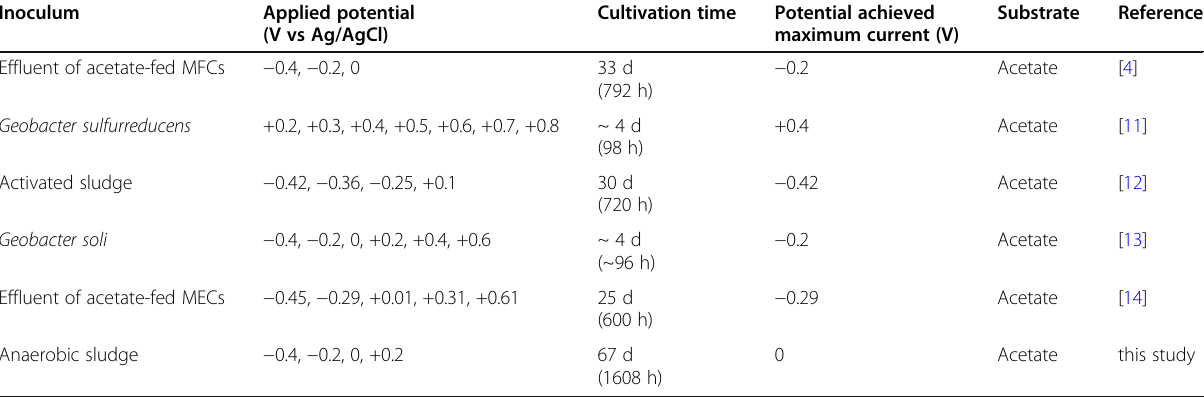
Table 1 Comparisons of acetate-based systems utilizing applied potential to harvest anode EAB Inoculum Applied potential Cultivation time Potential achieved (V vs Ag/AgCl) maximum current (V) Effluent of acetate-fed MFCs